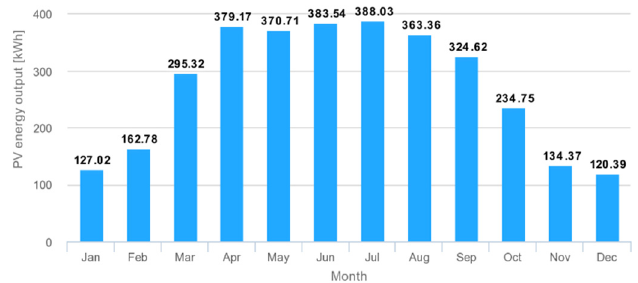
Figure 6. Monthly PV production—Case 1.